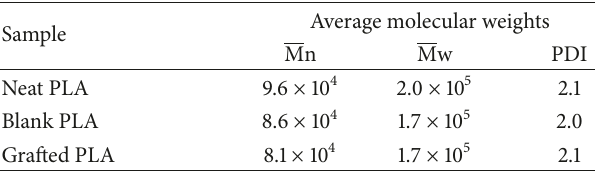
Table 1: GPC results of neat, blank, and grafted PLA